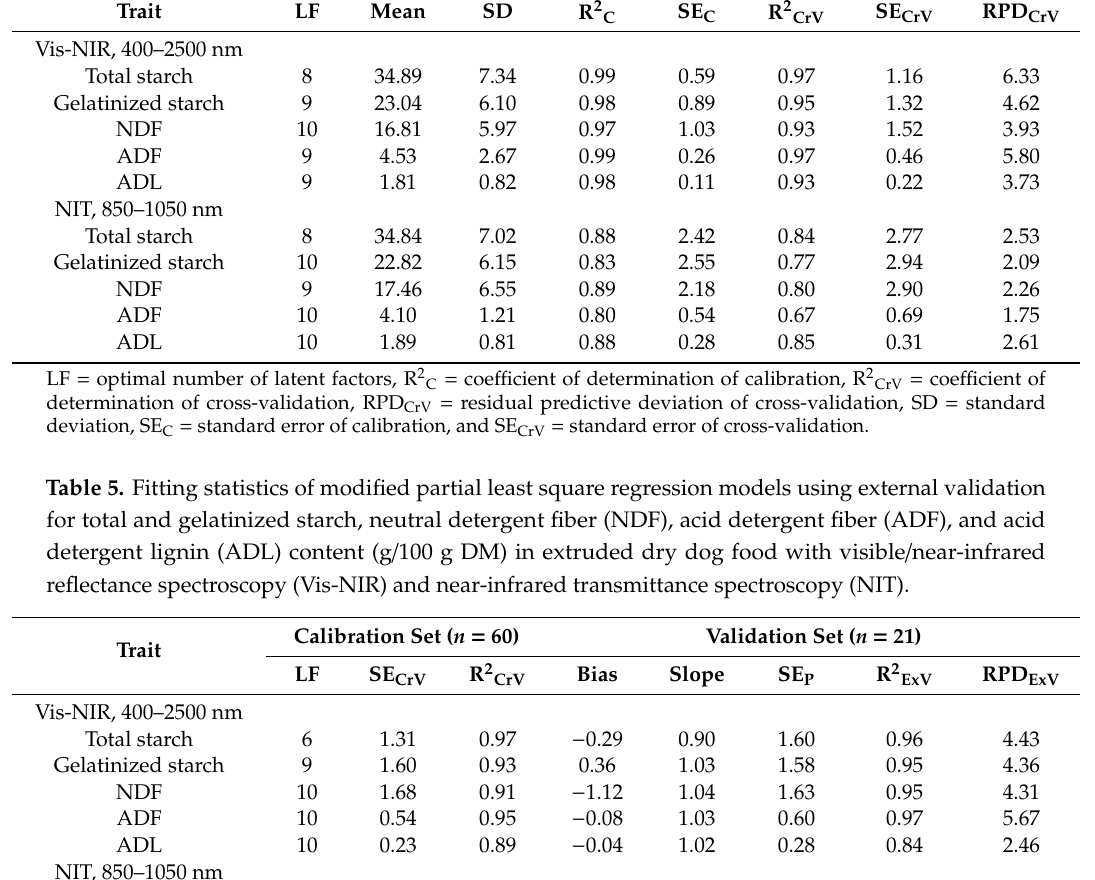
Table 4. Fitting statistics of modified partial least square regression models using one-leave-out cross-validation ( n = 81) for total and gelatinized starch, neutral detergent fiber (NDF), acid detergent fiber (ADF), and acid detergent lignin (ADL) content (g / 100 g DM) in extruded dry dog food with visible and near-infrared reflectance spectroscopy (Vis-NIR) and near-infrared transmittance spectroscopy (NIT). Trait LF